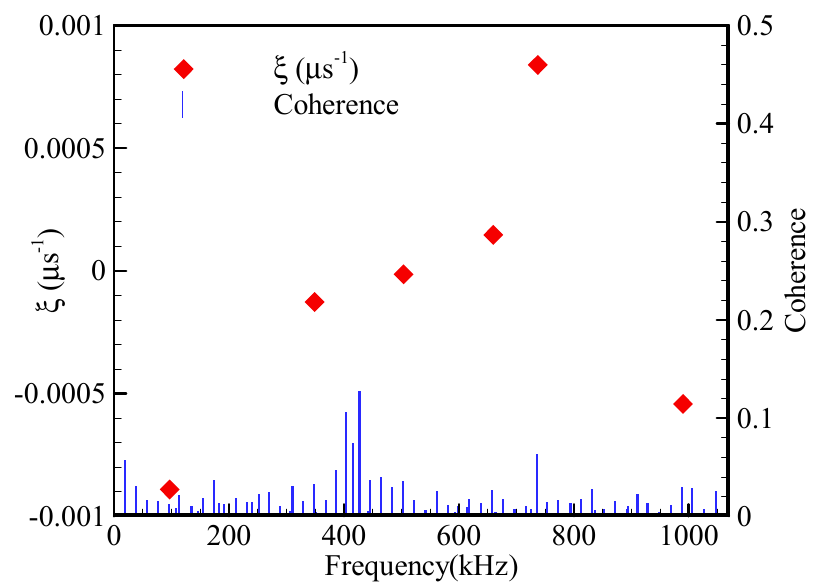
Figure 17. Temporal characteristics of decomposed modes using DMD with UCSD reaction mecha- nism for 200 × 300 grid resolution (red dot—growth factor; blue line—normalized coherence).